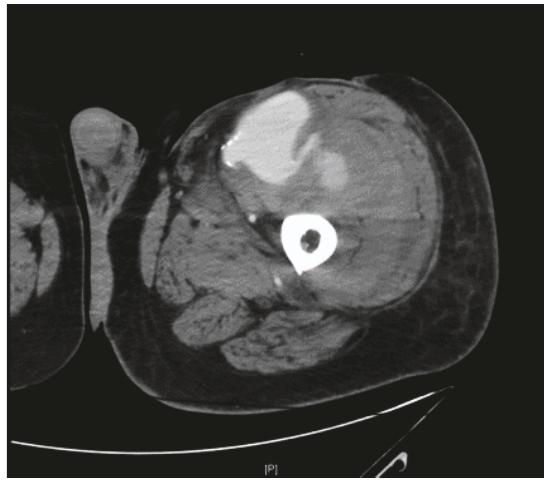
Figure 1: CTA of left lower extremity, axial images showing the anastomosis pseudoaneurysm with active extravasation.